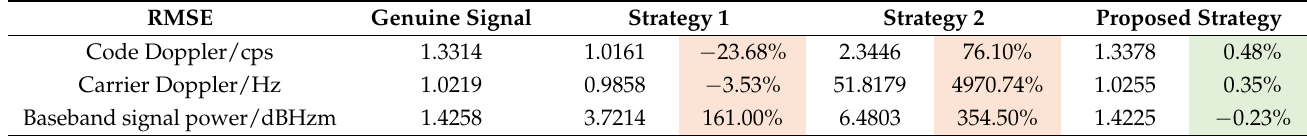
Table 6. Comparison of RMSE of different strategies and the genuine signal (C/N 0 = 50 dBHz, D = 1).